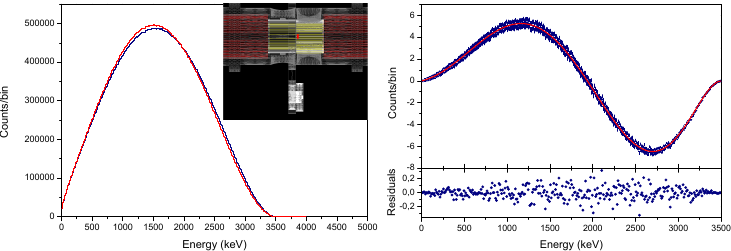
Figure 3. Left panel: the generated energy spectrum with Eq. (2) (in blue), and the deposited energy within the two YAP scintillators obtained by GEANT4 simulation (in red). Insert: the simulation geometry with the source of events placed between the two YAP scintillators (the red spot). Right panel: on top, the histogram of the normalized di ff erence between the generated and deposited energy histograms (in blue). The fit of this histogram with a polynomial function (in red). On bottom, the residuals of the